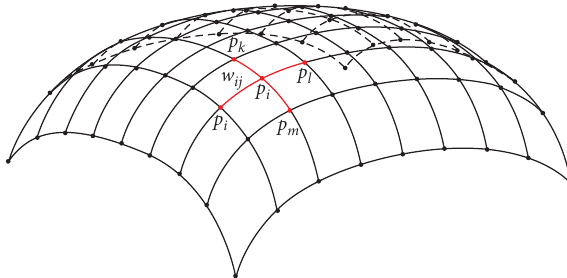
Figure 2: Riemannian graph from Riemannian